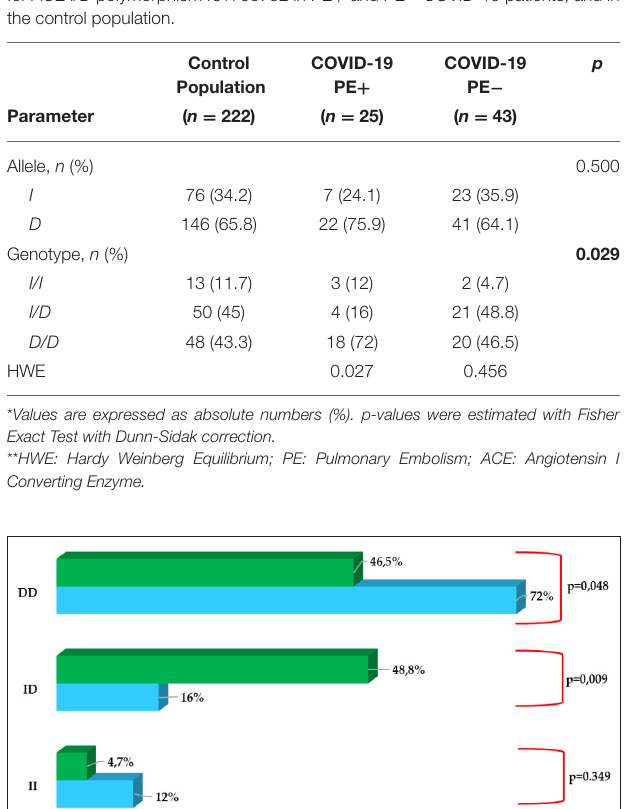
0.025), whilst no difference emerged as between CP and PE − (0.447 > 0.050).